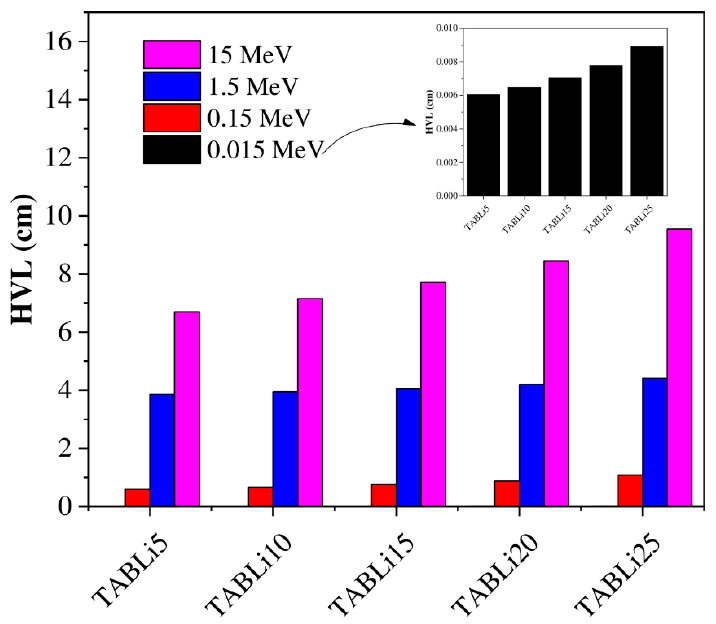
Figure 11. Variation of the investigated glasses’ half-value layer versus LiO 2 concentration.